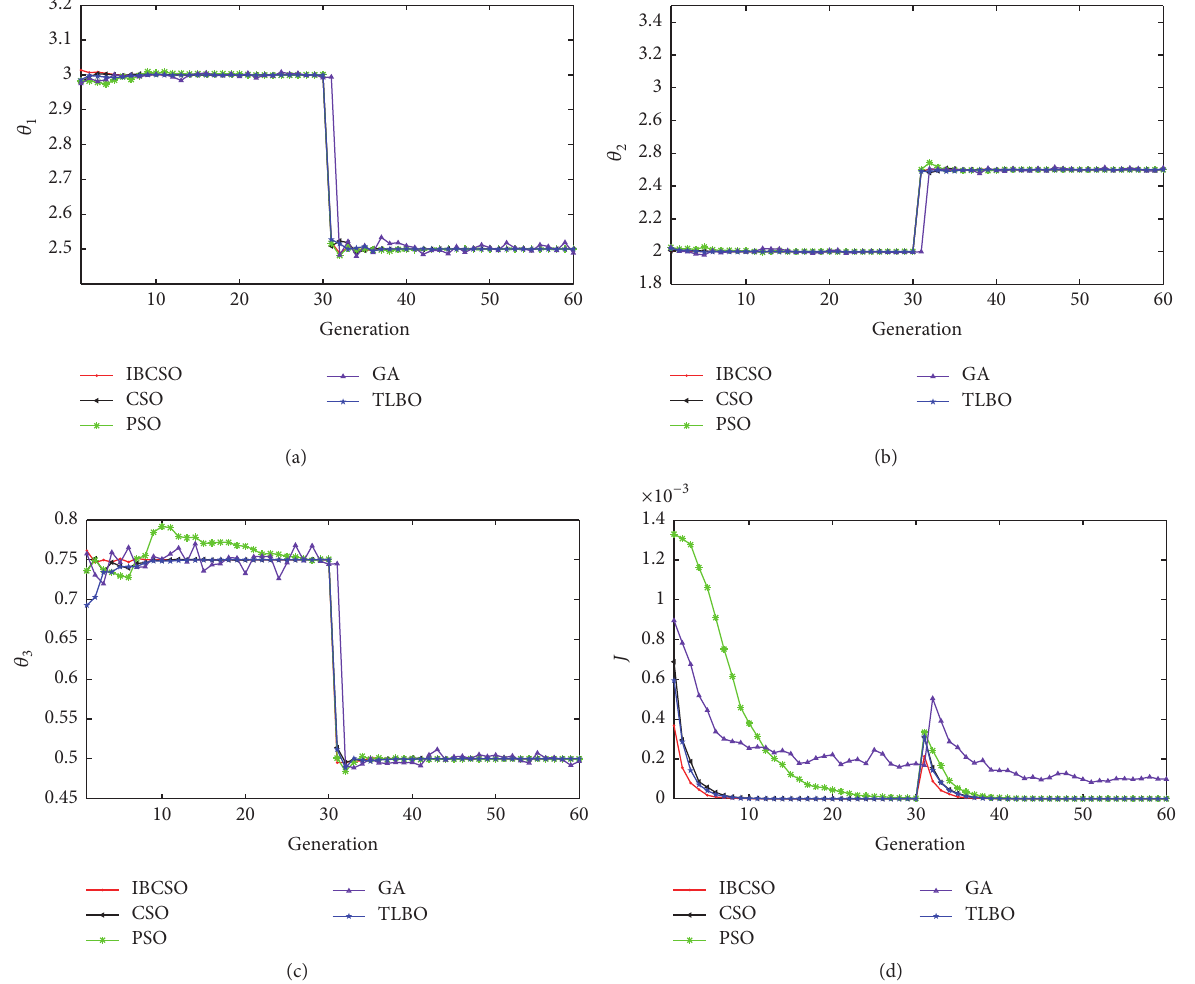
Figure 6: The evolving process of the average values obtained by IBCSO, CSO, PSO, GA, and TLBO in online mode. (a) 𝜃 1 ; (b) 𝜃 2 ; (c) 𝜃 3 ; (d) 𝐽